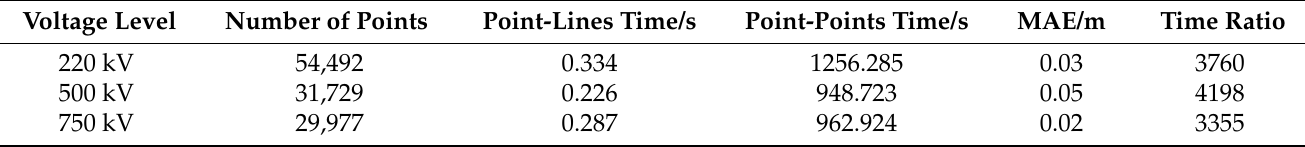
Table 3. Average time consuming and MAE in one span.